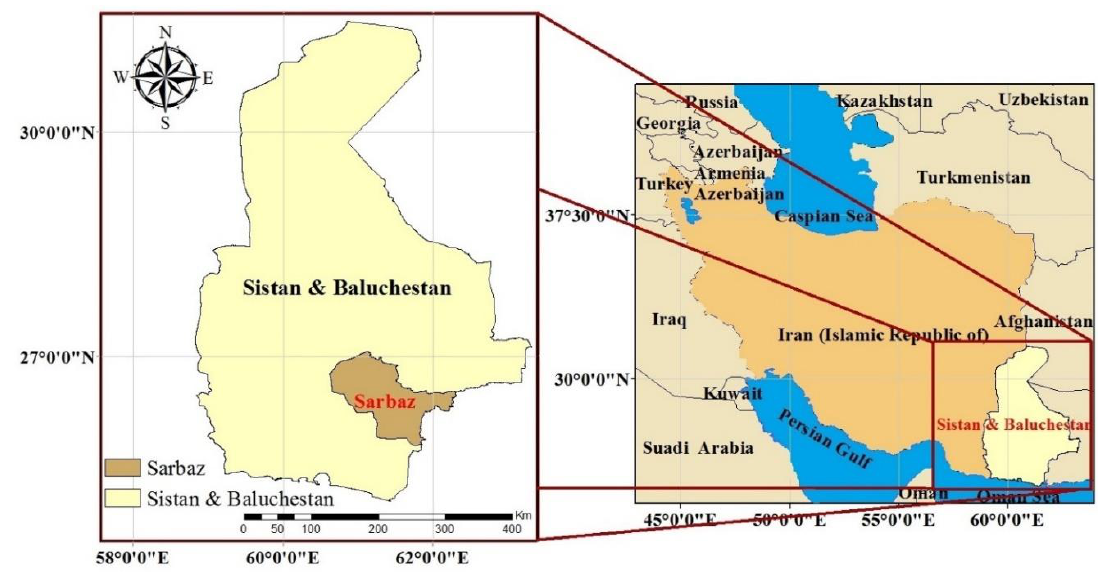
Figure 1. Geographical location of the study area, namely Sarbaz county in the province of Sistan and Baluchestan, Iran.